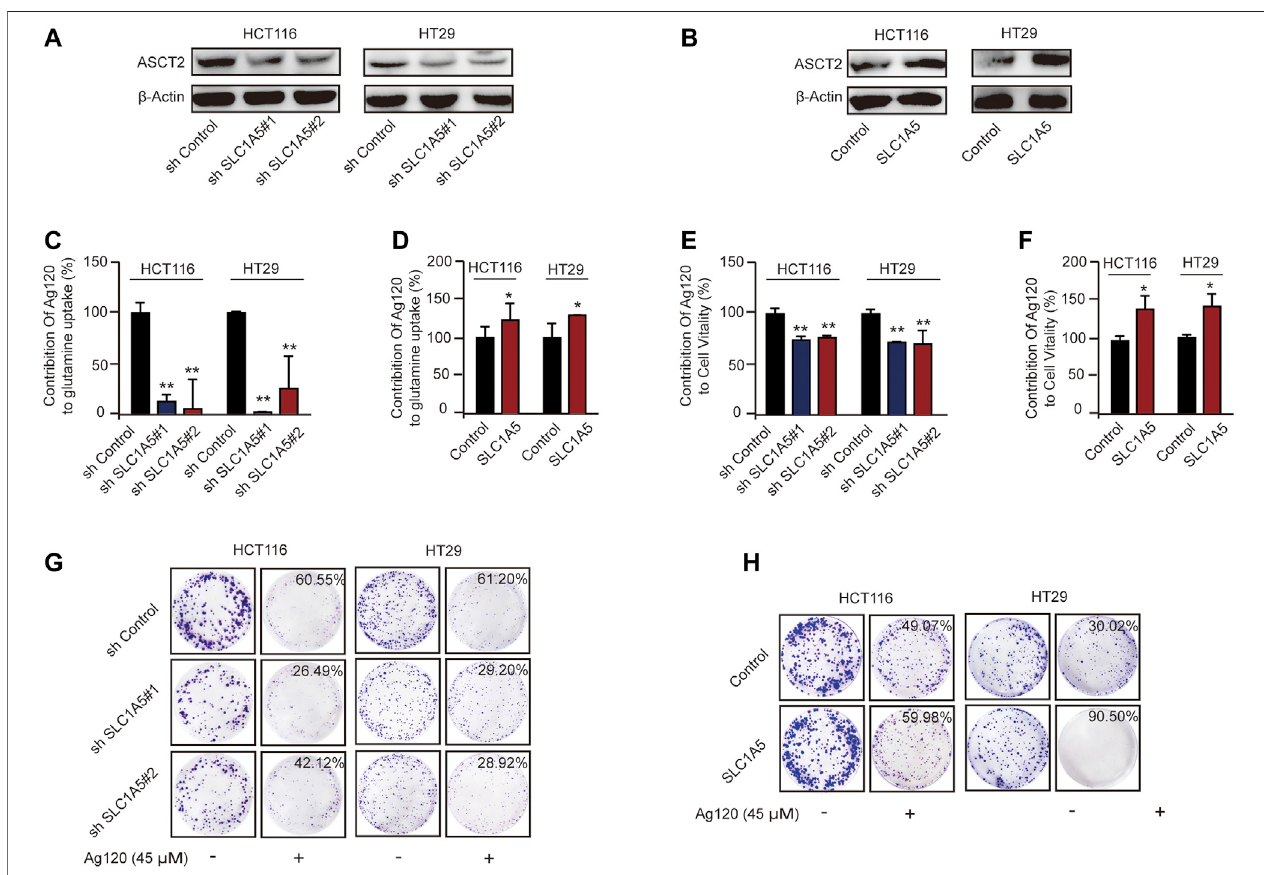
FIGURE 5 | Effects of Ag120 on glutamine metabolism and proliferation in CRC cells following ASCT2/SLC1A5 knockdown or overexpression. (A,B) Immunoblot analysis of ASCT2 in HCT116 and HT29 cells stably transfected with ASCT2 shRNA (shSLC1A5#1/shSLC1A5#2) or control shRNA (A) or stably transfected with a controlorSLC1A5DNA-lipidoverexpressioncomplex (B) . (C,D) GlutamineuptakeinSLC1A5-depleted orSLC1A5-overexpressingHCT116 andHT29 cellstreatedfor 2 h with Ag120 (15 µM). The contribution of Ag120 to glutamine uptake was calculated based on the data in Supplementary Figures S4C,D . (E,F) Viability of SLC1A5-depletedorSLC1A5-overexpressingHCT116andHT29cellstreatedfor72 hwithAg120(45 µM)wasquanti fi edusingaCCK-8kit.ThecontributionofAg120 to cell viability was calculated based on the data in Supplementary Figures 4E,F . (G,H) As described for (E,F) except colony formation was measured after 10 days. Mean ± SD of three experiments. * p < 0.05, ** p < 0.01 by Student ’ s t